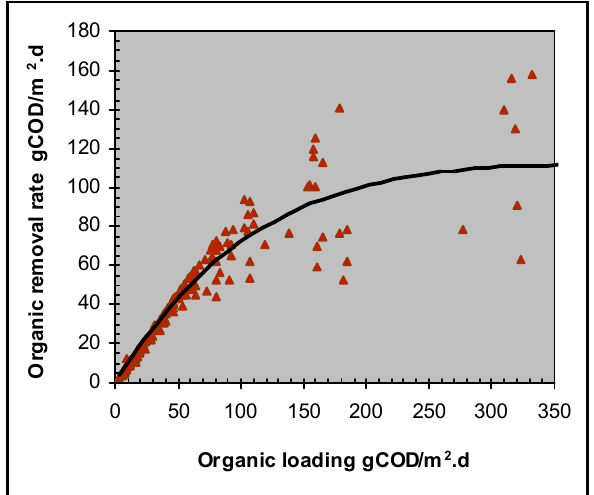
Figure 16: Effect of total applied organic loading on organic removal rate under various operational